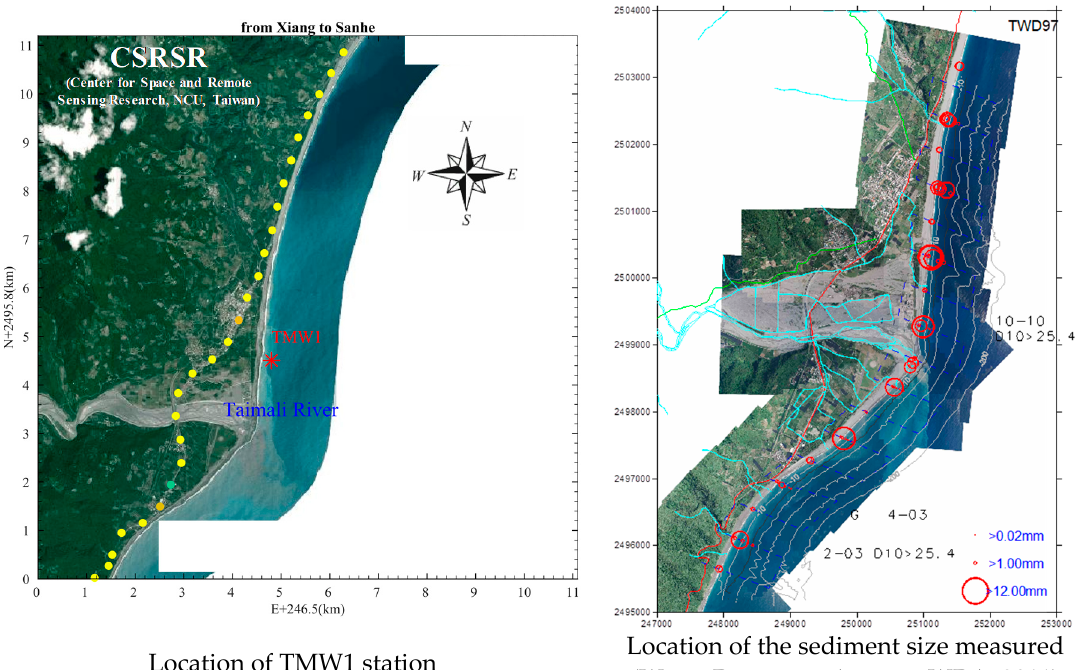
Figure 12. Locations of TMW1 station and the sediment size measured.